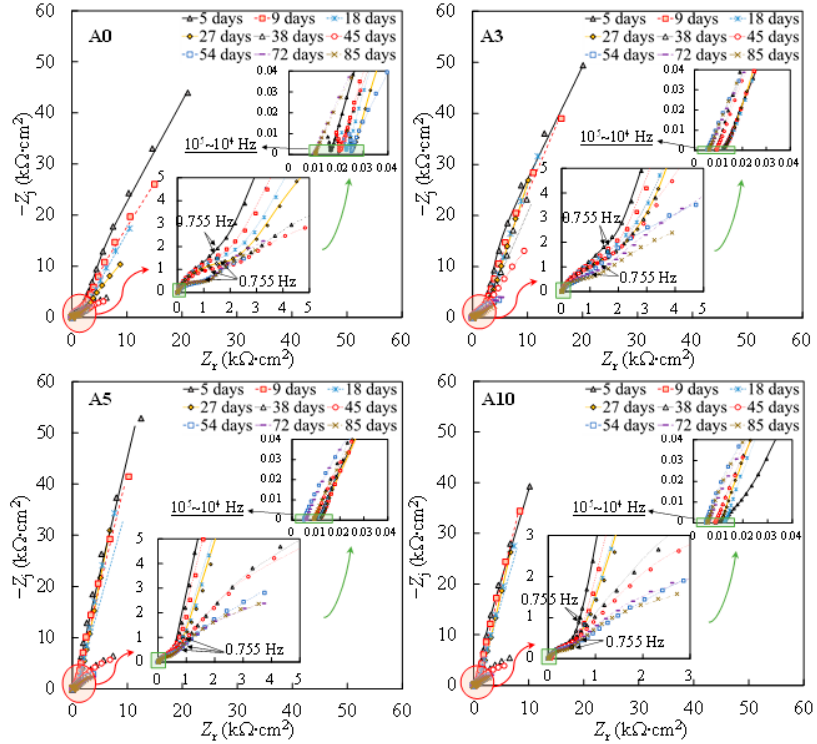
Figure 2. Nyquist plots of individual specimens subjected to different levels of tensile stress. Symbol: experimental results. Line: fitting results.